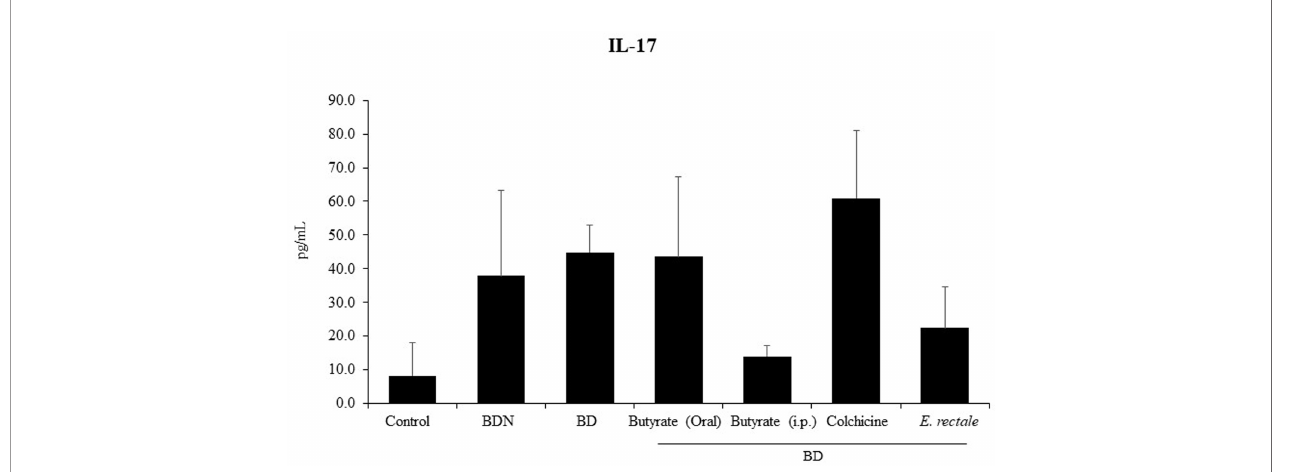
FIGURE 9 | Serum IL-17 levels in BD mice treated with butyrate orally or intraperitoneally, E. rectale , or colchicine were analyzed by ELISA. The p-value was determined by the Kruskal-Wallis